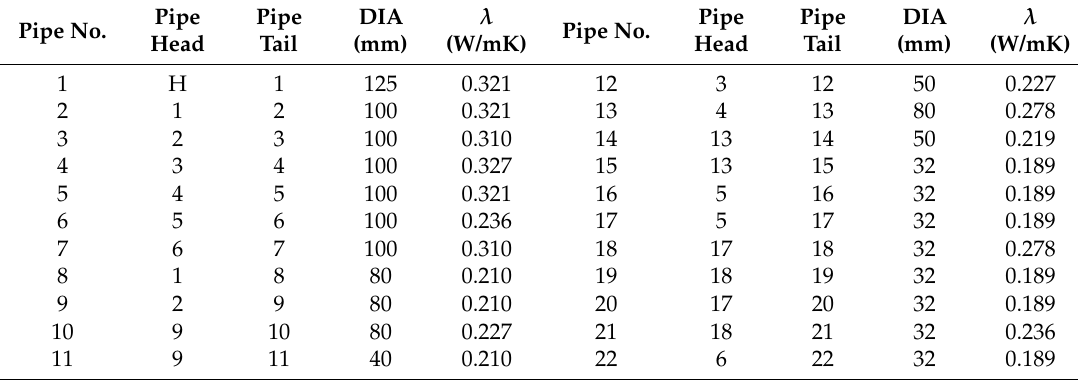
Table A1. Line parameters of the 23-node district heating (H is the thermal source). Pipe